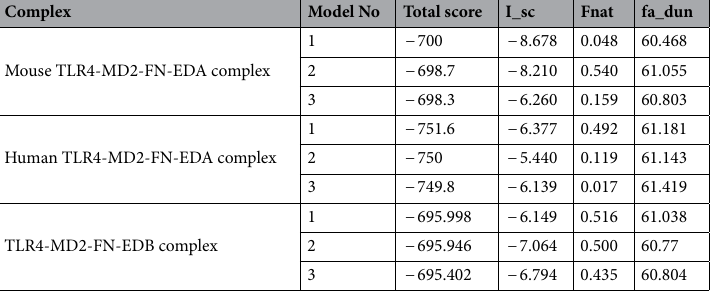
Table 1. FN-EDA and FN-EDB top 3 docked model complexes with TLR4-MD2 obtained from RosettaDock. Total score, Overall energy of the docking complex in kcal/mol; I_sc, Interface energy, which is the sum of the energies of individual protein partners in isolation, subtracted from the total score of the docked complex; Fnat, It is the fraction of the native contacts recovered in the docked model; fa_dun, Probability of obtaining native-like side chain rotamers using Dunbrack’s